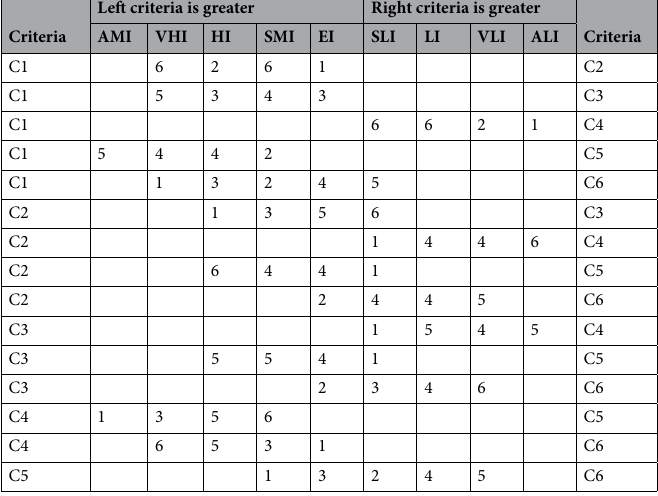
Table 6. The pairwise comparison matrix of the SF-AHP model.